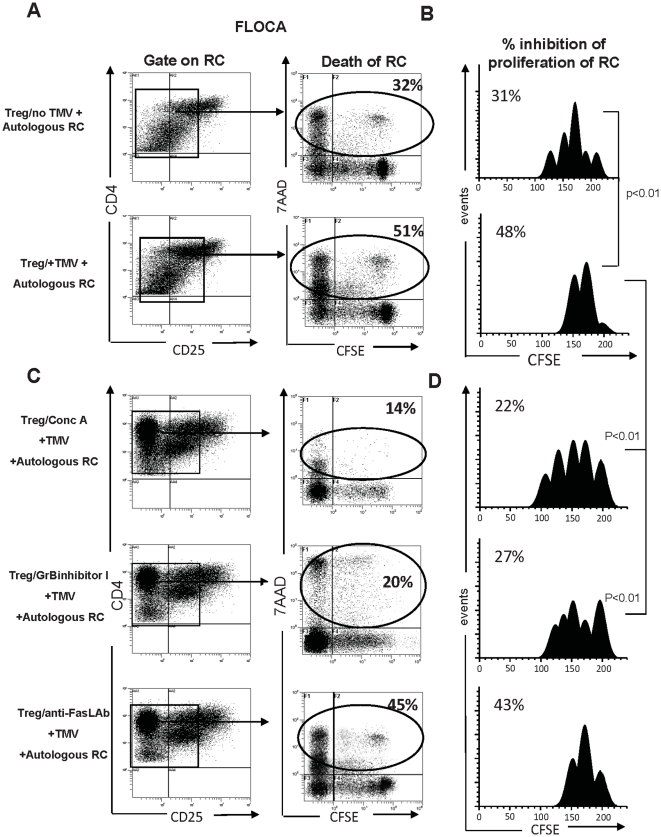
TMV increase suppressor activity of Treg.The FLOCA was used to simultaneously measure suppression proliferation of CFSE-labeled autologous CD4+CD25neg RC and their apoptosis upon co-incubation with CFSE-negative Treg. RC cells stimulated with OKT3, anti-CD28 mAb and IL-2 (150 IU/mL) were co-cultured for 5 d with Treg pre-incubated or not with TMV. At harvest, cells were stained with 7-AAD and examined by flow cytometry. The suppressor assays were performed at the S:RC ratio of 1∶1. Treg pre-incubated with TMV induced higher levels of apoptosis (A) and greater inhibition of RC proliferation (B). The data are from one experiment of five performed. When Treg were pretreated with Concanamycin A or GrB inhibitor I and then incubated with TMV, the frequency of 7-AAD+ RC was lower (C) as was RC proliferation inhibition (D). Treg pretreated with FasL Ab and then incubated with TMV induced RC death (C) and inhibited RC proliferation (D).